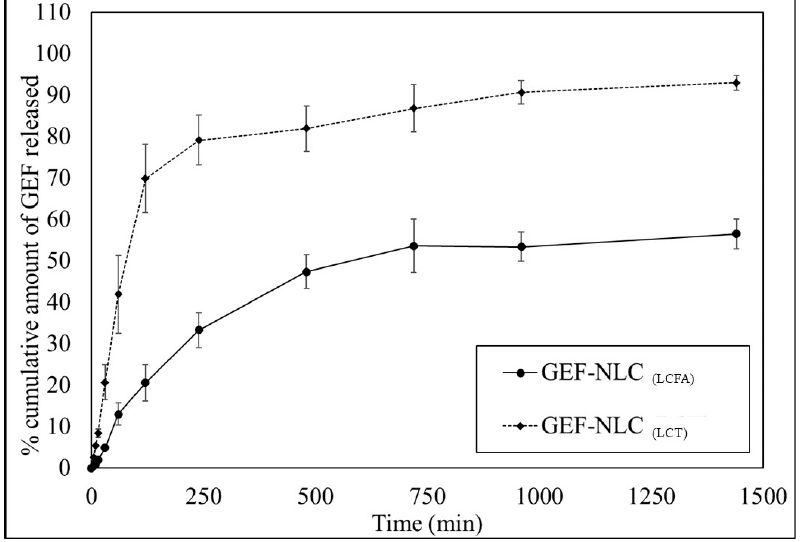
Figure 8. In vitro release of GEF from GEF-NLC (LCFA) and GEF-NLC (LCT) formulations. Data are expressed as the mean ± SD, N = 3.